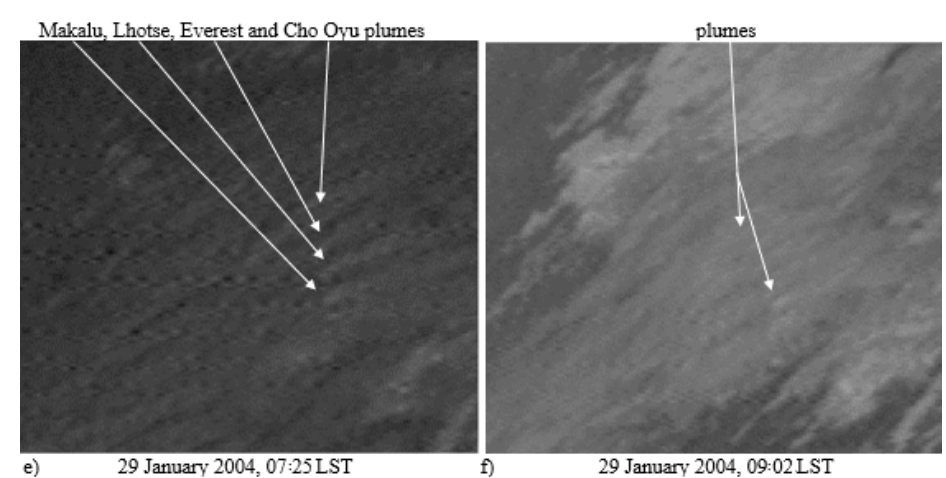
Figure 8. (a–f) GOES-9 0.65µm images of the study region. The major features are labeled.